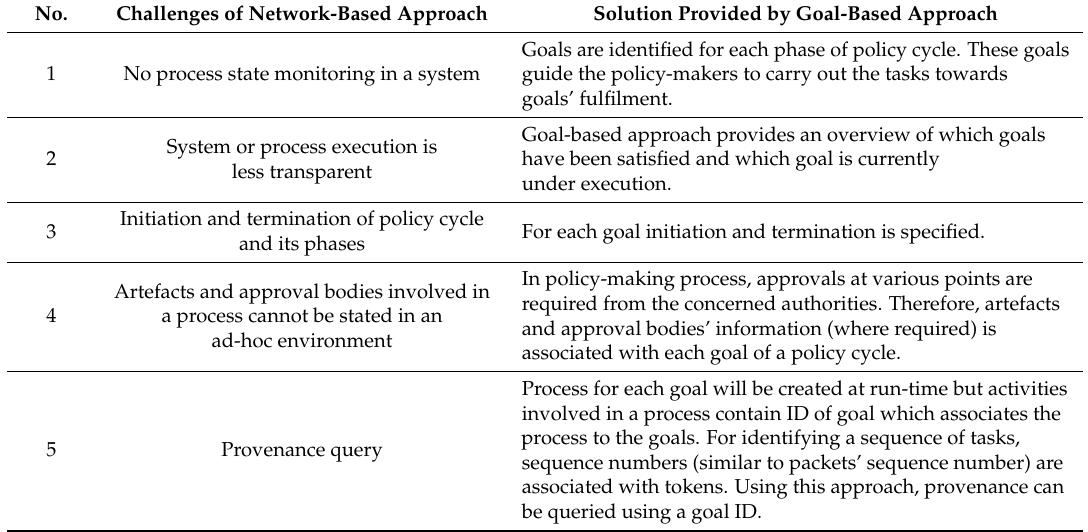
Table 4. The Benefits of a Goal-based